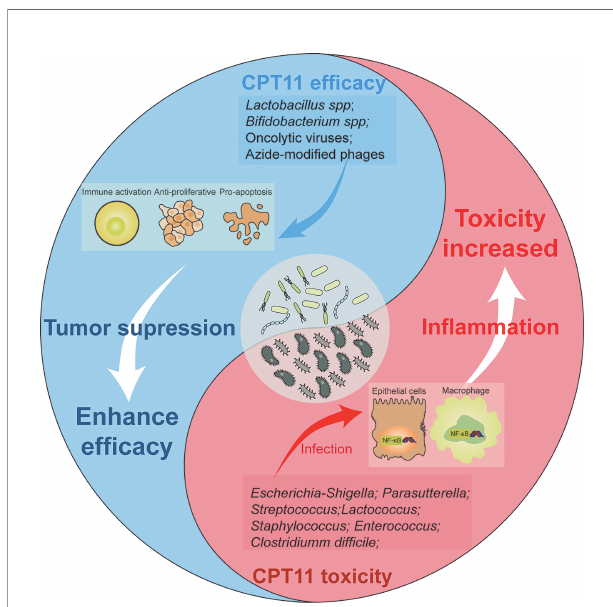
FIGURE 2 | Effects of microbiota on the trend of CPT11 chemotherapy ef fi cacy and toxicity. Schematic presents the dualism ’ s functional role of microbiota in CPT11 chemotherapy. Lactobacillus spp , bi fi dobacterium spp , oncolytic viruses, and azide-modi fi ed phages can cooperate with CPT11, respectively, and exert immune activation, synergetic anti-proliferative and pro-apoptosis effect on tumor. That eventually enhances the anti-tumor ef fi cacy on tumor. However, some microbes, such as Escherichia-shigella , Parasutterella , Streptococcus , Lactococcus , Staphylococcus and Clostridium dif fi cile elicit a series of in fl ammation response by activating NF- k B pathway after infection of macrophages and epithelial cells, which aggravate the toxic reactions induced by CPT11, and impair chemotherapeutic